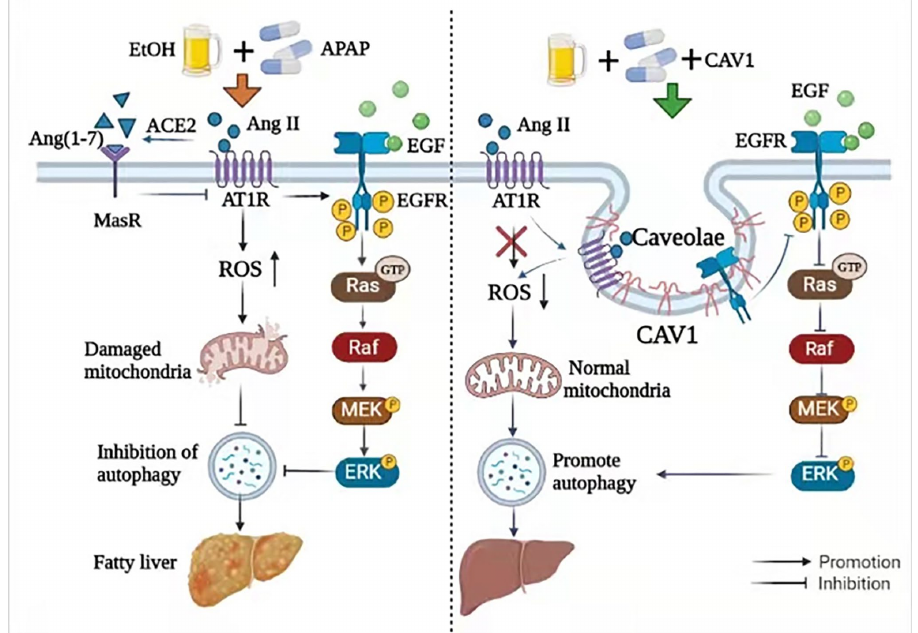
Figure 9. CAV1 alleviates APAP-induced lipid accumulation in AFLD by regulating the Ang II/EGFR/ERK axis, ameliorating oxidative stress, and restoring autophagic flux. EtOH , ethanol; APAP , acetaminophen; ACE2, angiotensin-converting enzyme 2; Ang II, angiotensin II; EGFR, epidermal growth factor receptor; MAPK/ERK, mitogen-activated protein kinase.